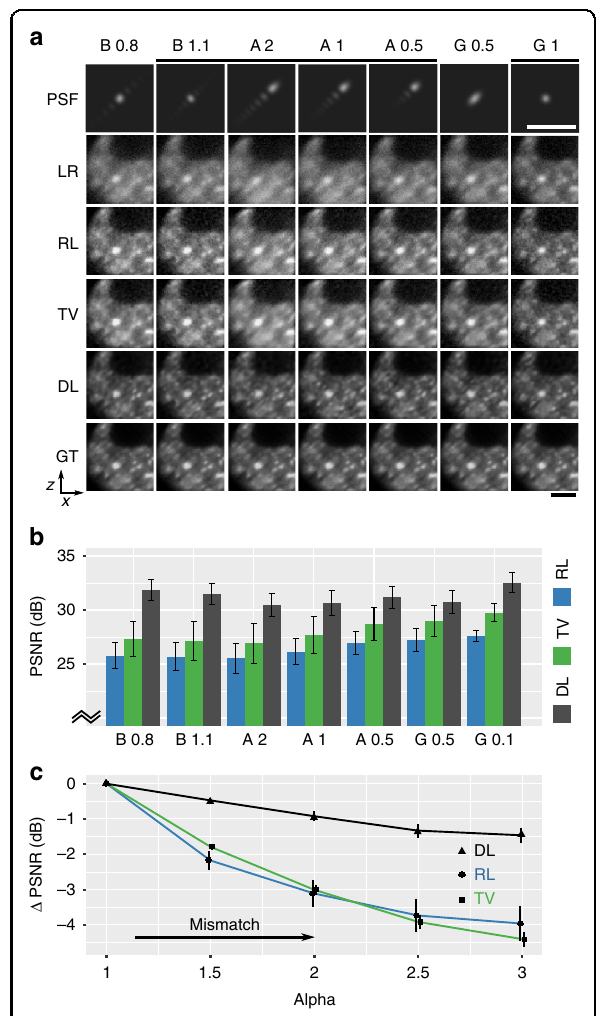
Fig. 2 Comparison of deep learning (DL), Richardson – Lucy (RL) deconvolution and RL deconvolution with total variation (TV) regularisation in simulated data. a Deconvolution of low- resolution noisy images (LR) simulated using beams (B: Bessel; A: Airy; G: Gaussian) visualised by their point-spread function (PSF) (parameters listed in “ Methods ” ) using RL, TV and DL algorithms and compared to the ground truth (GT). Scale bar is 20 μ m. b Mean peak signal-to-noise ratio (PSNR) of RL, TV and DL deconvolution for each beam shape evaluated in 240 simulated images (error bar is the standard deviation). c Relative change in PSNR in deconvolution of an Airy beam due to model mismatch. RL, TV and DL assume that the Airy α = 1; however, LR images were simulated with α in range [1,